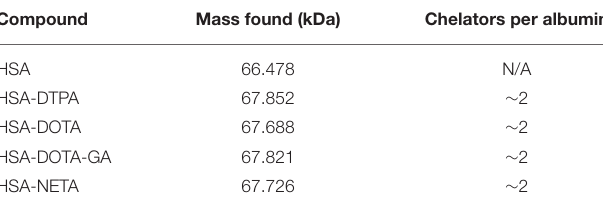
TABLE 1 | Mass spectrum data of HSA and compounds L-HAS. time period of 24 h using instant thin-layer chromatography